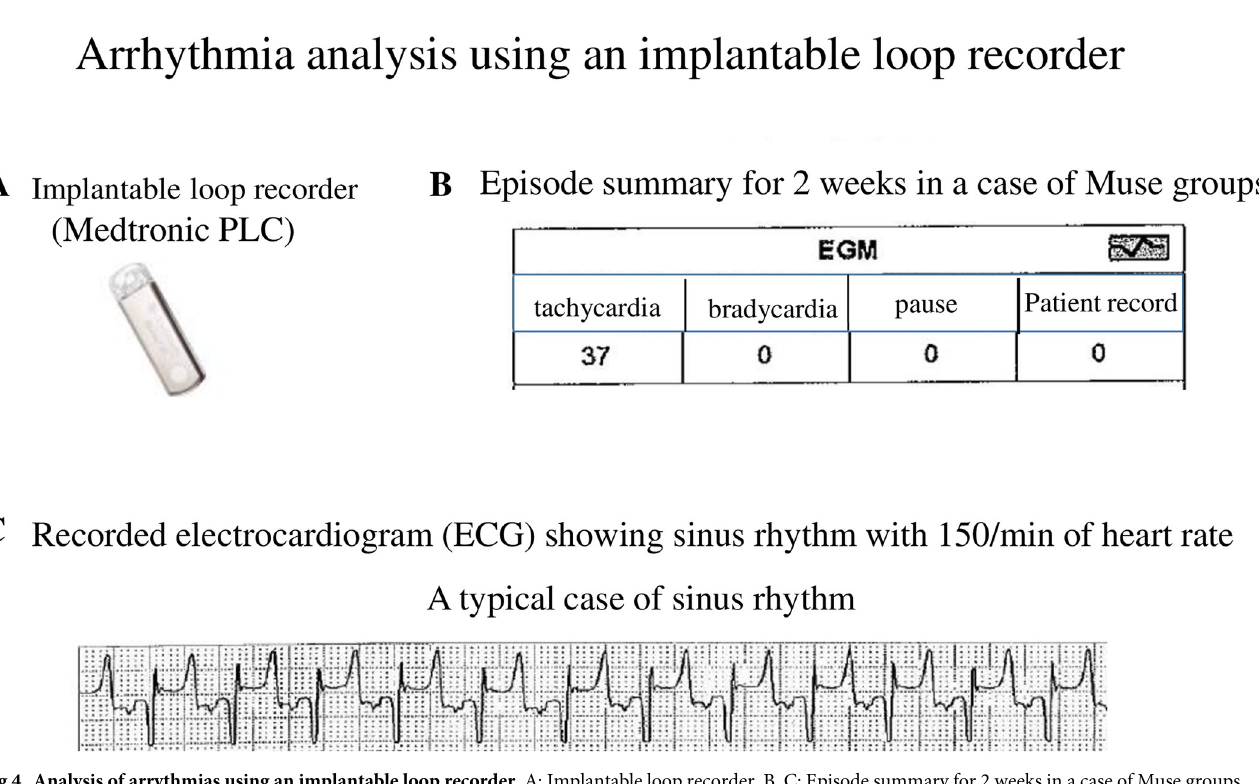
the heart at a high rate of * 14% of the injected Muse cells, which was mediated through the S1P-S1PR2 axis; an interaction between sphingosine-1-phosphate (S1P) produced in the dam- aged heart and S1P receptor 2 (S1PR2) located on Muse cells [13]. The engrafted autograft GFP-labeled Muse cells expressed the cardiac markers ANP, troponin I, and α -actinin at 2 weeks and 2 months after AMI, and expressed the vascular endothelial marker CD31 and vas- cular smooth muscle marker α -smooth muscle actin at 2 weeks, suggesting that Muse cells